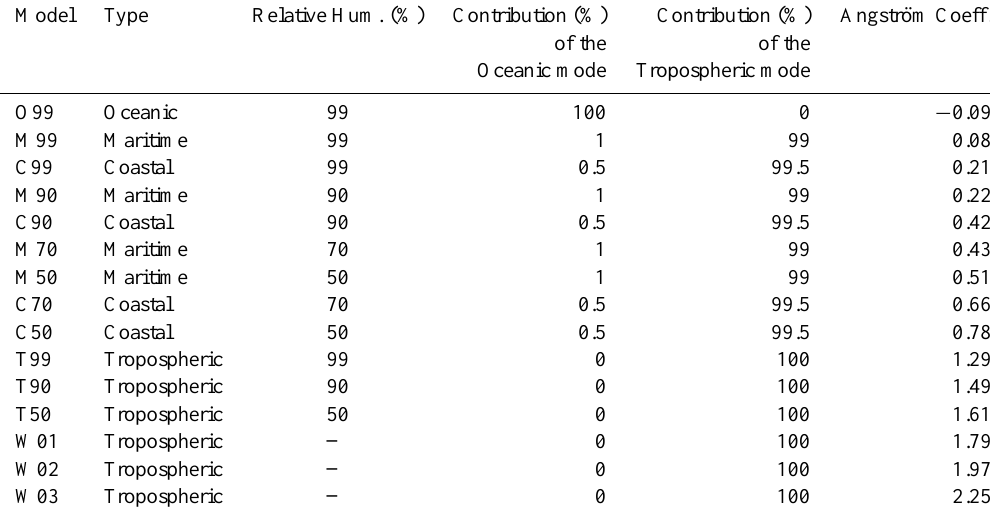
Table 1. Characteristics of the aerosol models used in this study. They are all made of a mixing of the oceanic and tropospheric lognormal modes of Shettle and Fenn (1979), except for the W01, W02 and W03 models. These three models were derived from the tropospheric mode at a relative humidity of 0% by decreasing the mean radius from 0.027 µ m (original value) to 0.021, 0.017 and 0.015 µ m, respectively. Note that the Angstr¨om coefficient is computed between 0.63 and 0.81 µ m and that the contribution of both Oceanic and tropospheric modes are in number (not in volume or in surface). Model Type Relative Hum. (%) Contribution (%) Contribution (%) Angstr¨om